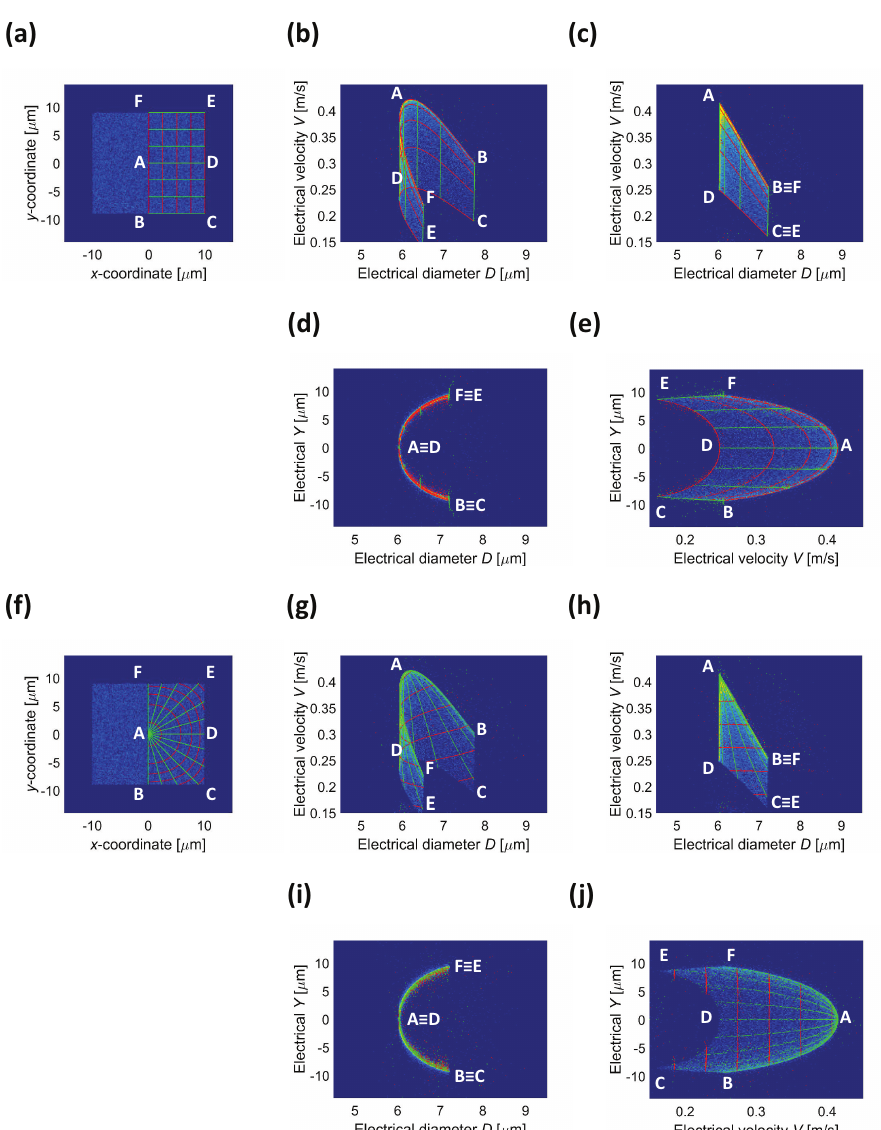
Figure A1. Facing electrode chip. ( a , f ) Density plot of x - and y -coordinates of event centers (uniformly distributed in the channel cross-section, allowing a 2 µ m gap of the 6 µ m diameter beads from the microchannel walls). Additional events along ( a ) iso- x and iso- y lines, or ( f ) iso- v and iso- θ lines, are marked in red and green, respectively. Six significant positions are labeled with letters from A to F. ( b , g ) Density plots of electrical velocity V vs. electrical diameter D relevant to particle distributions in ( a , d ), obtained using the conventional wiring scheme (data stream F conv electrical velocity V vs. electrical diameter D obtained using the new wiring scheme (data stream F new The latter also yields ( d , i ) density plots of electrical height Y vs. electrical diameter D , and ( e , j ) density plots of electrical height Y vs. electrical velocity V